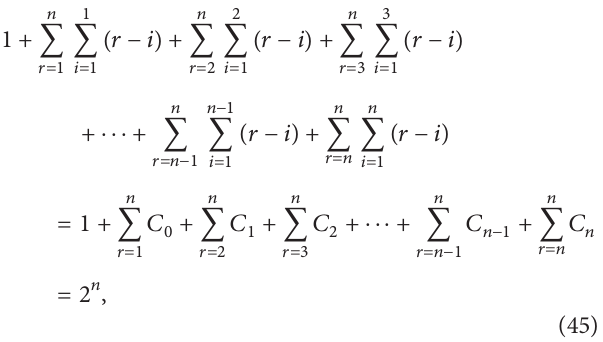
sampling pattern for all 𝑇 𝑥 s. Based on this algorithm, for a typical indoor environment having 5 sampling points, the worst case search tree can be generated, as shown in Figure 9.